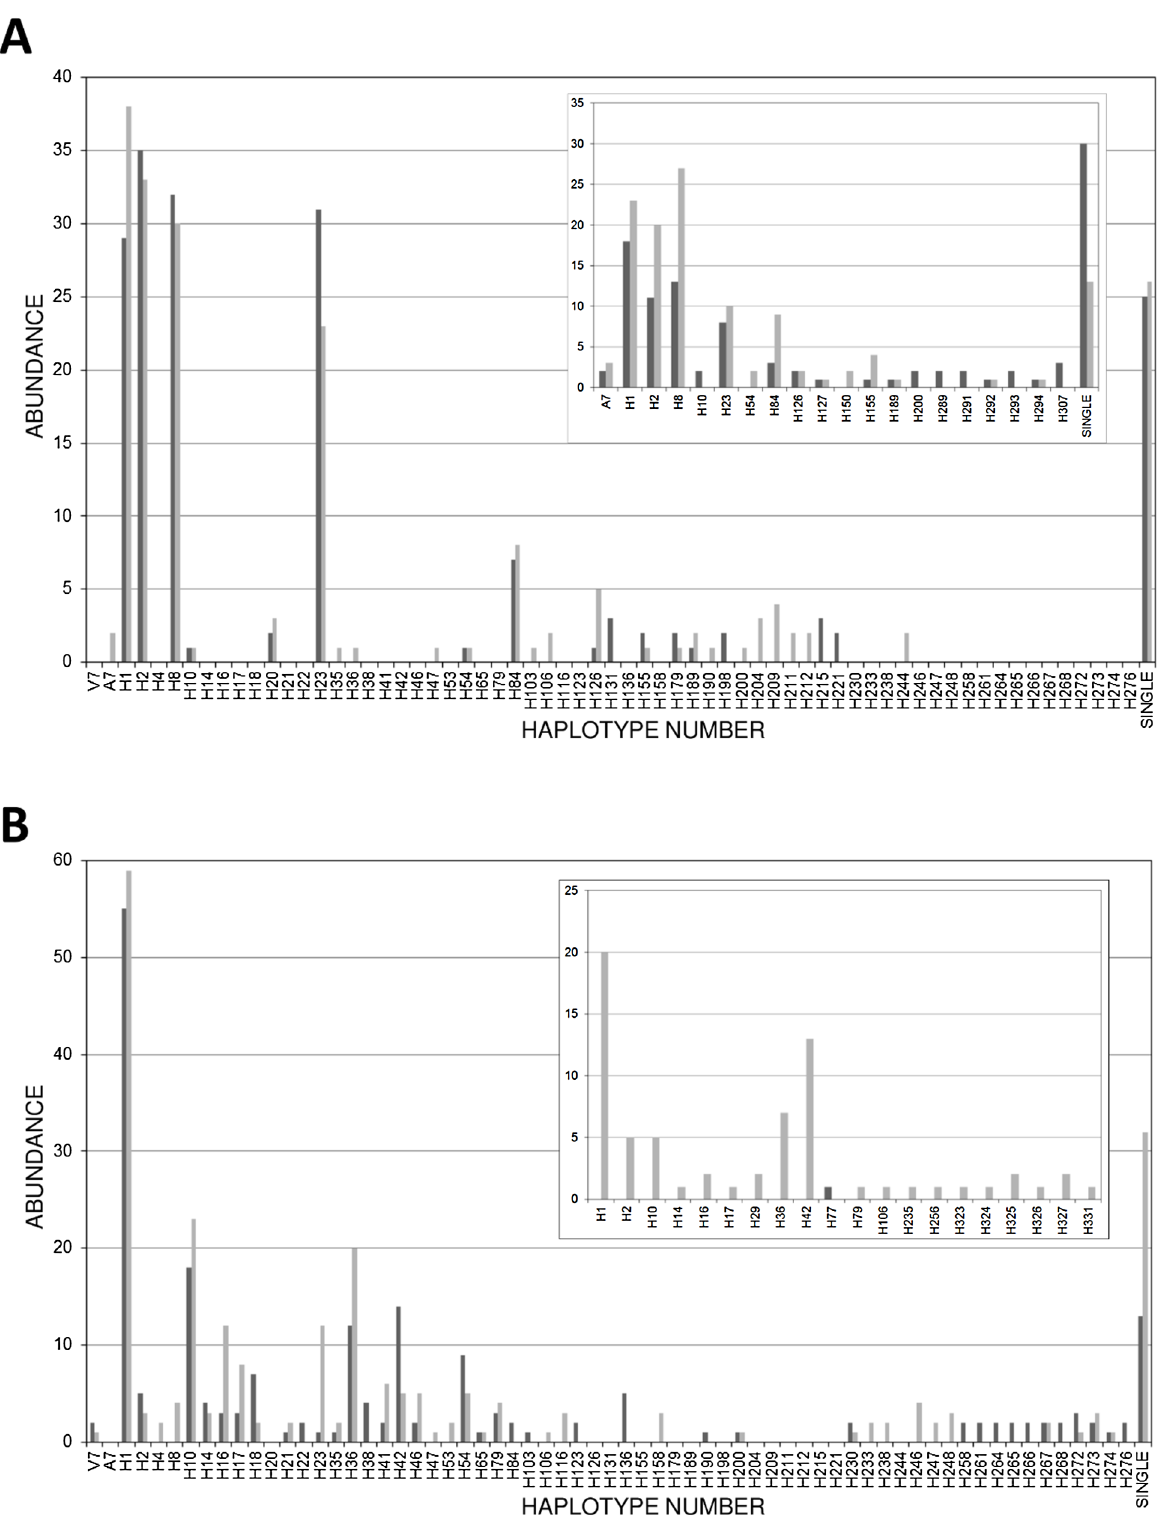
Figure 1. Haplotype abundance barcharts for Lake Albert (A) and Lake Victoria (B). The main barcharts display haplotypes recovered during the baseline surveys and the inset barcharts display haplotypes isolated during the six-month follow up surveys. Dark grey bars indicate haplotypes identified in mothers whereas light grey bars represent haplotypes isolated from children. ‘‘Single’’ refers to unique haplotypes which were only identified once during the surveys.